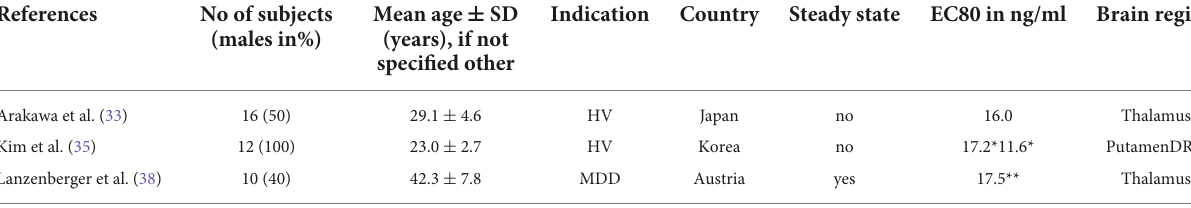
TABLE 2 EC 80 values from neuroimaging